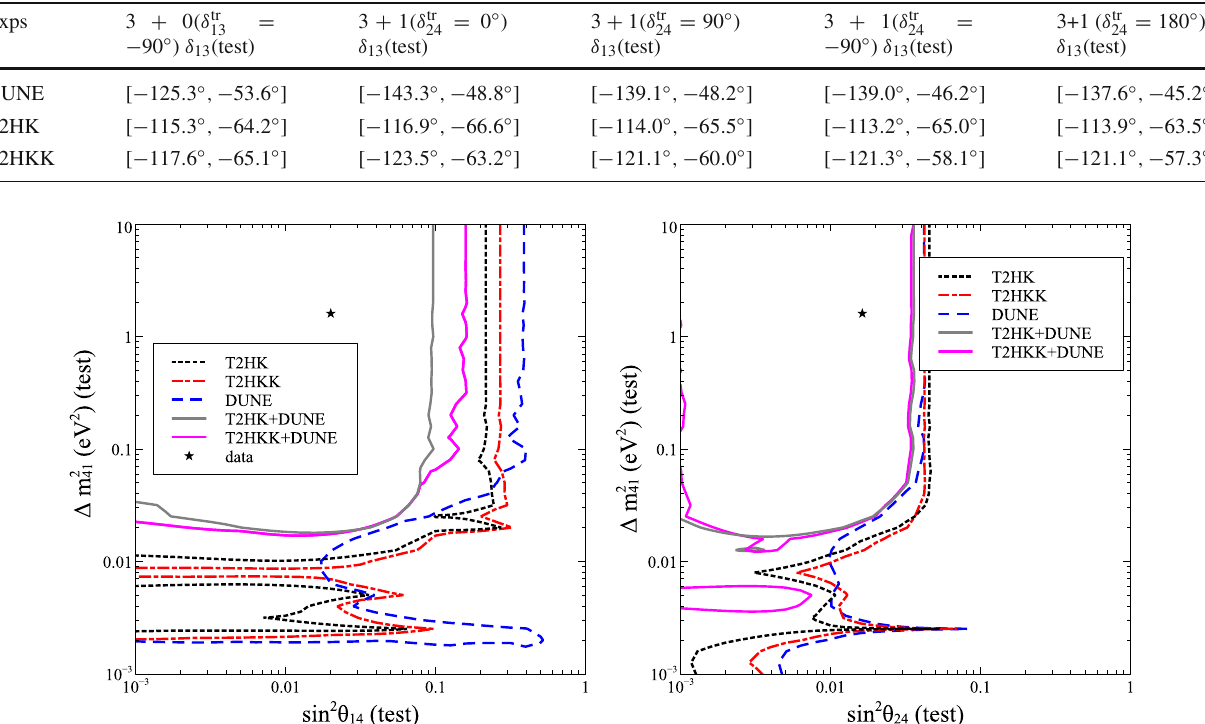
δ tr = 0 ◦ , 90 ◦ , − 90 ◦ , 180 ◦ . Here δ tr stands for δ (true) 13 (test) for 24